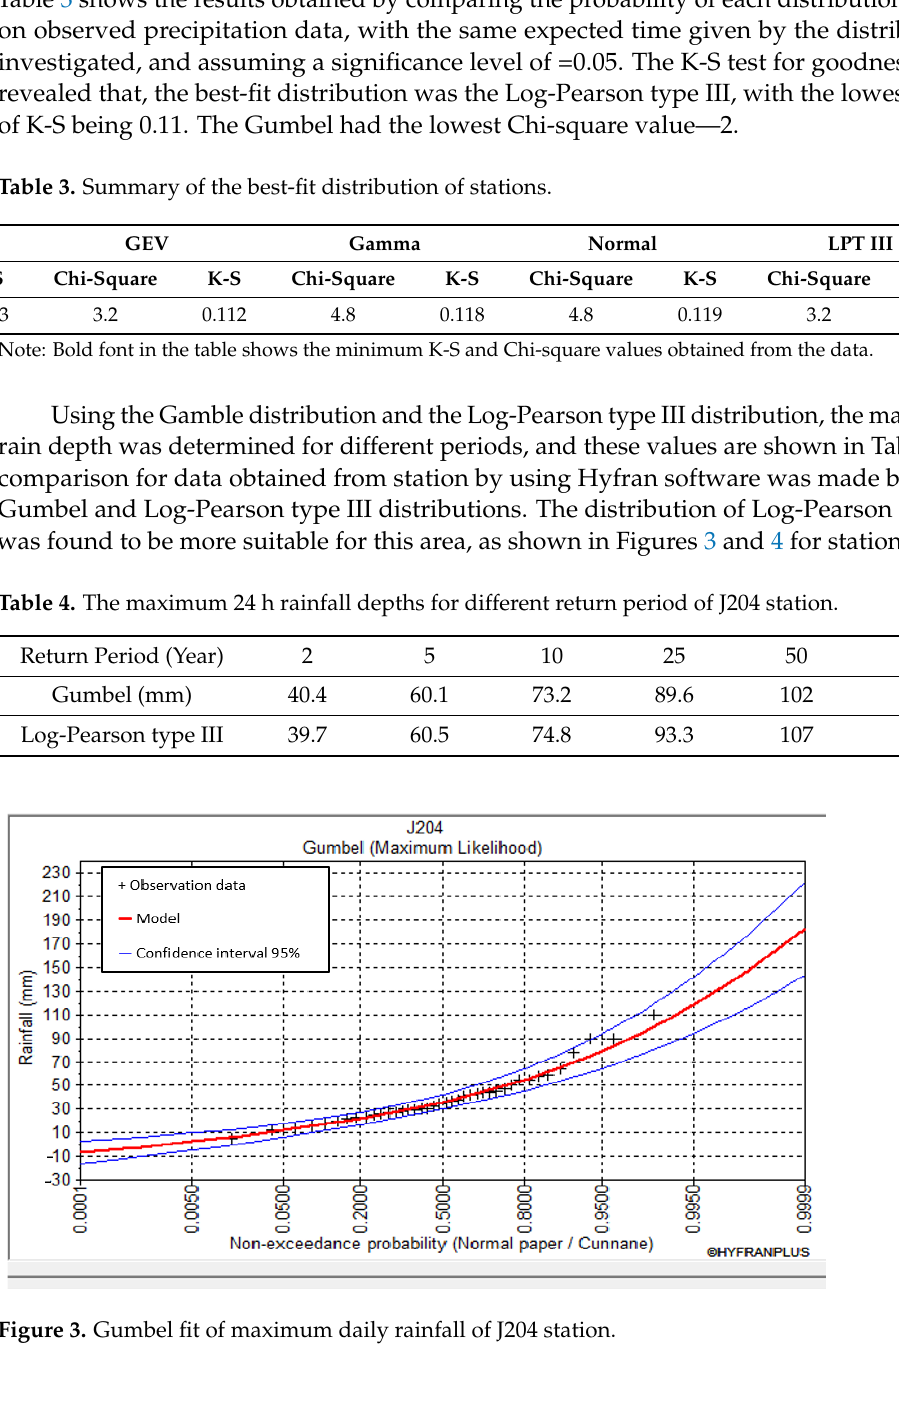
Figure 4. Log-Pearson type 3 fit of maximum daily rainfall for J204 station. Figure 4 shows the non-exceedance probability with 95% confidence intervals for the station. Forecasting return periods of up to 100 years with just 30 years of data available leads to substantially less confidence in the outcomes as the return period grows. In these scenarios, it is clear that the Log-Pearson type III offers a slightly greater range. The con- fidence interval is relatively broad when the sample size is not too large. As the sample size grows, i.e., more meteorological data are collected over time, the width of the confi- dence interval around the estimated rainfall quantity will likely be narrow.